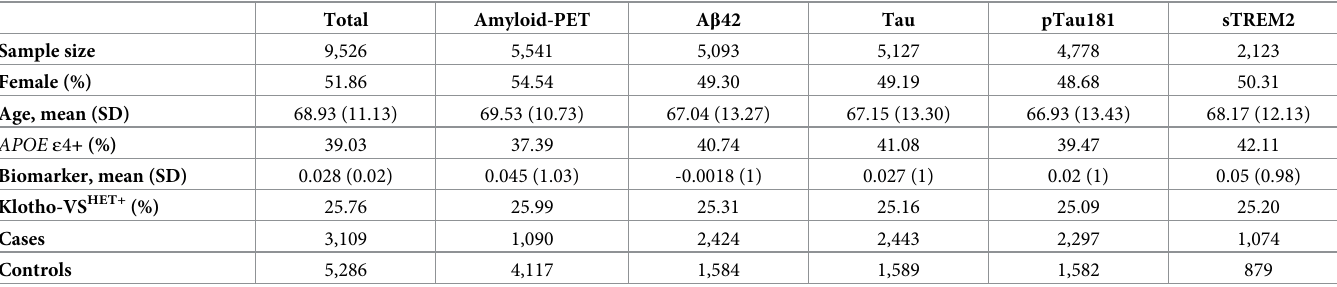
Table 1. Demographics of analyzed Alzheimer’s disease (AD) endophenotypes.